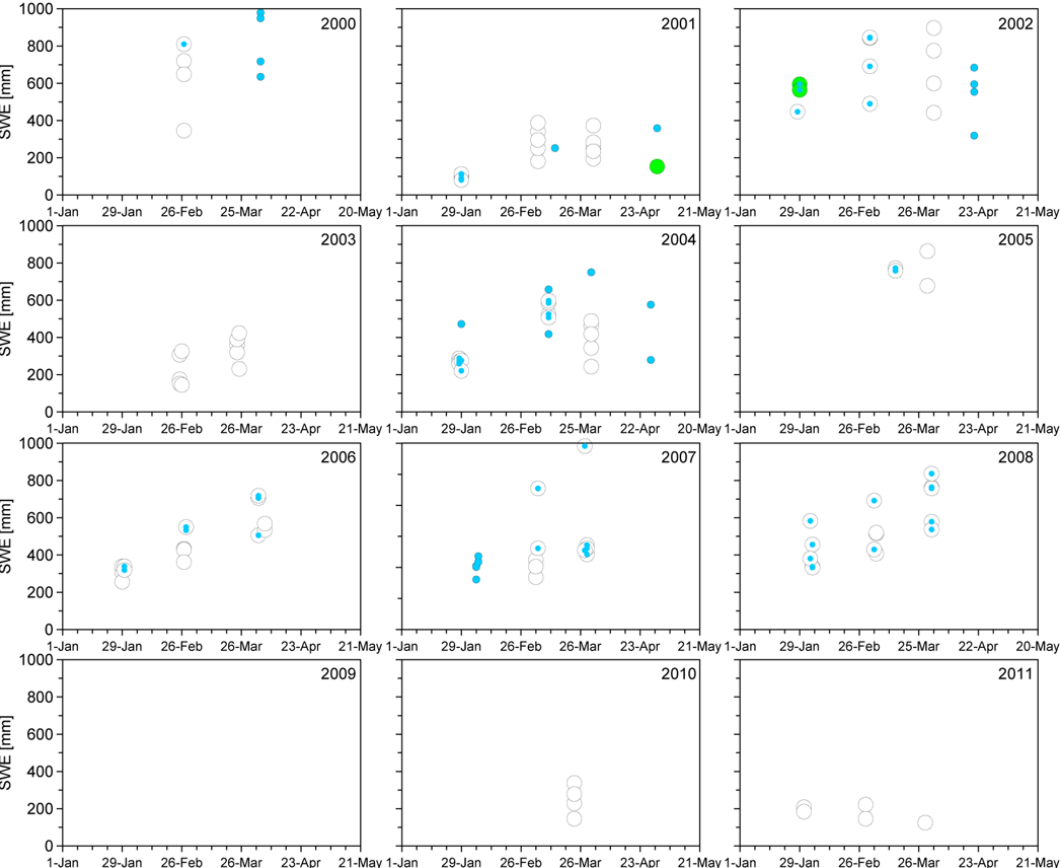
Fig. 4. Snow water equivalent (SWE) observations at open sites and MODIS classification at the respective pixels in individual snow seasons (2000–2011). Colors indicate MODIS snow (white), land (green) and cloud (blue) classifications. Overlapping of smaller (cloud) with larger (snow or land) symbols indicates the information is from the MODIS 2-day filter instead of the original cloud classification by MODIS for that